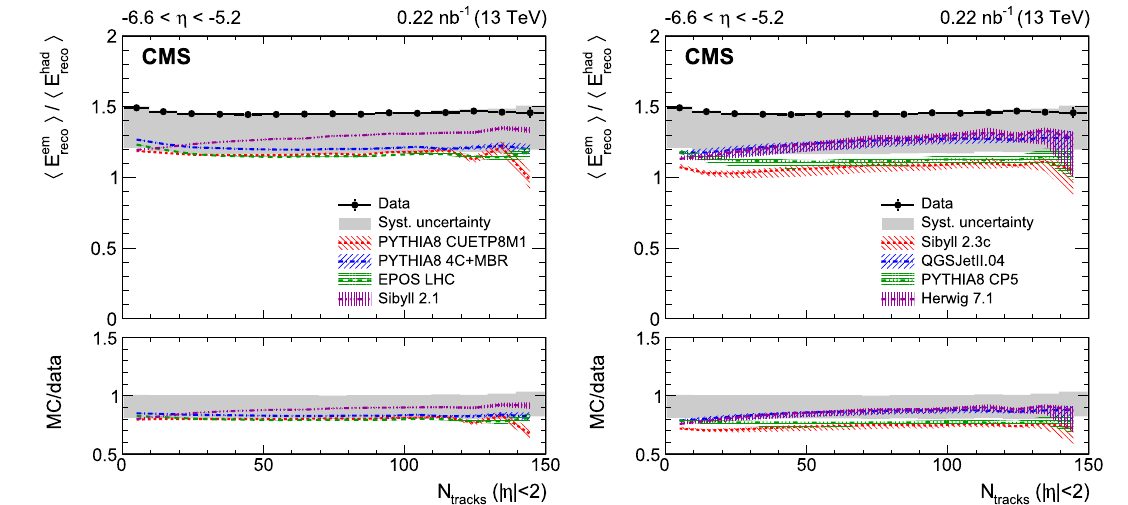
Fig. 3 Ratio of average electromagnetic and hadronic energies recon- structed in the CASTOR calorimeter as a function of the number of reconstructed tracks for | η | < 2. The data are shown with black circles and the corresponding systematic uncertainties with a gray band; hor-